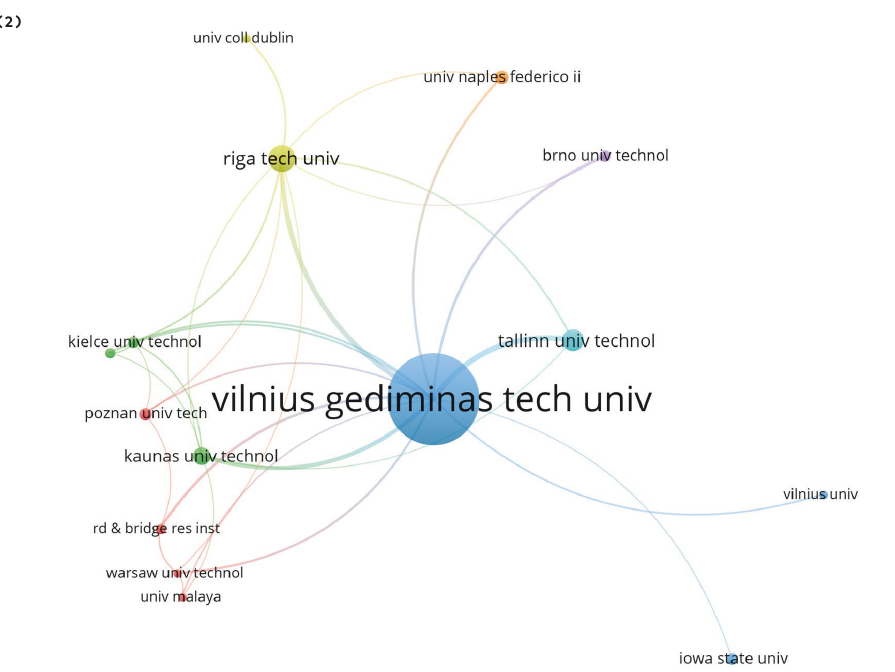
Figure 5. Organization citation network of the Baltic Journal of Road and Bridge Engineering